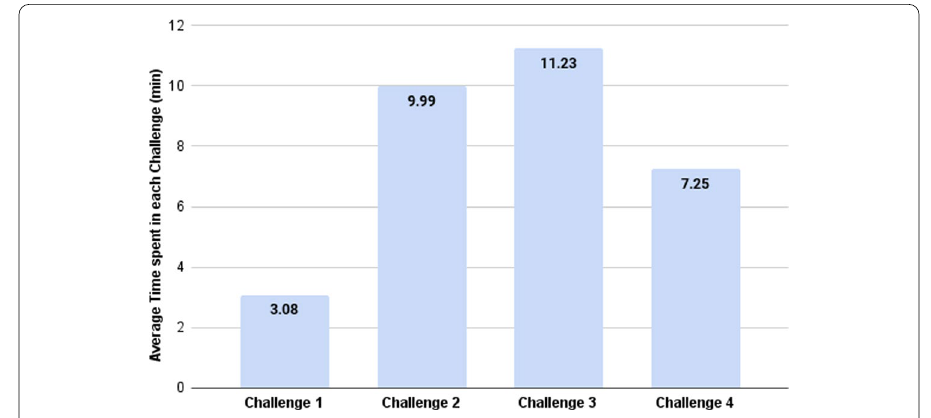
Fig. 14 Average time spent by 12 students in each challenge of the Design Tracing